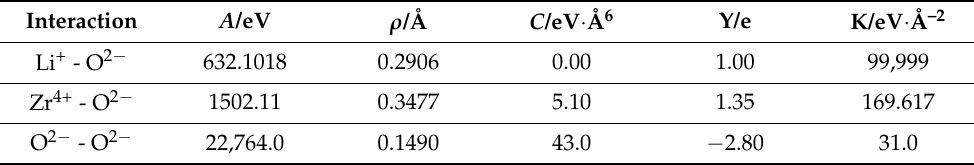
Table 1. Buckingham potential parameters used [18–20].